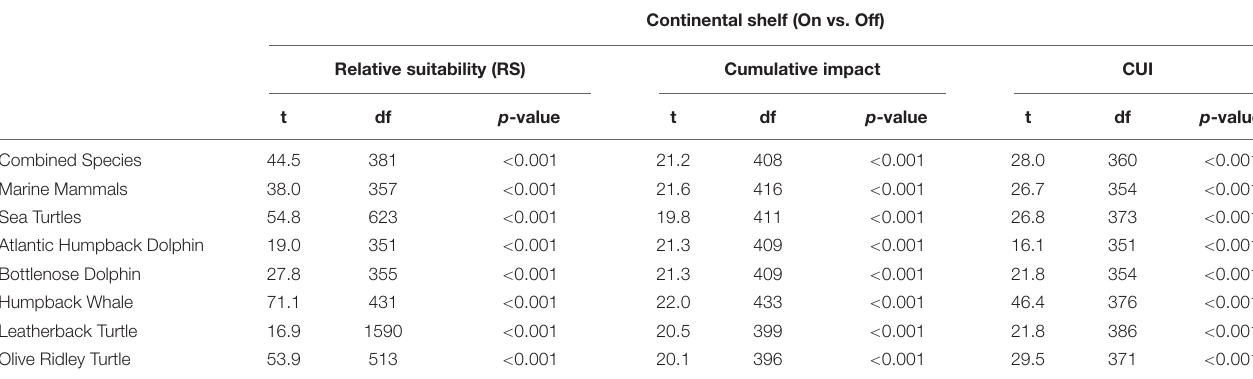
TABLE 2 | Welch’s t -test results for comparisons between means of relative suitability (RS), cumulative impact and cumulative utilization impact distributions on the continental shelf and off the continental shelf (open water) for all species groups and individual species studied. Continental shelf (On vs.